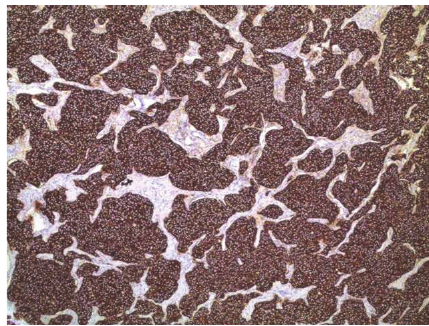
Figure 4: Primary tumor in breast, solid nests of uniform tumor cells with “salt and pepper” chromatin, X & @ , × 40.